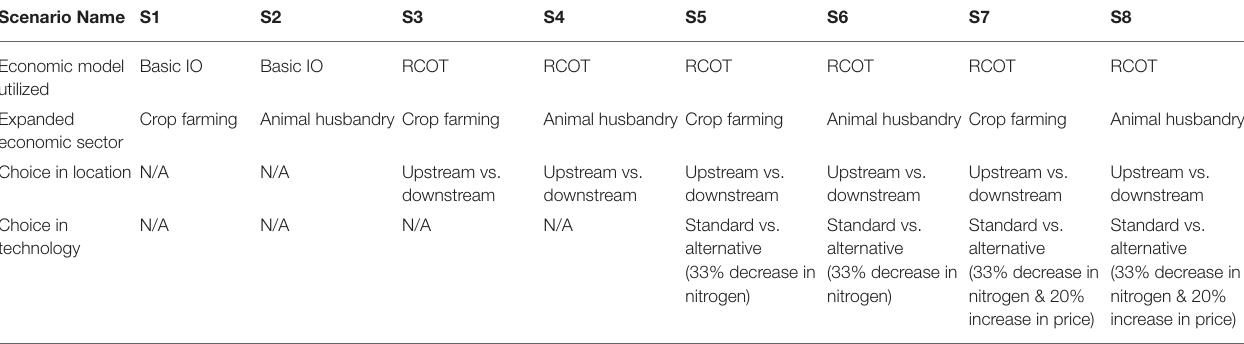
TABLE 2 | Summary of